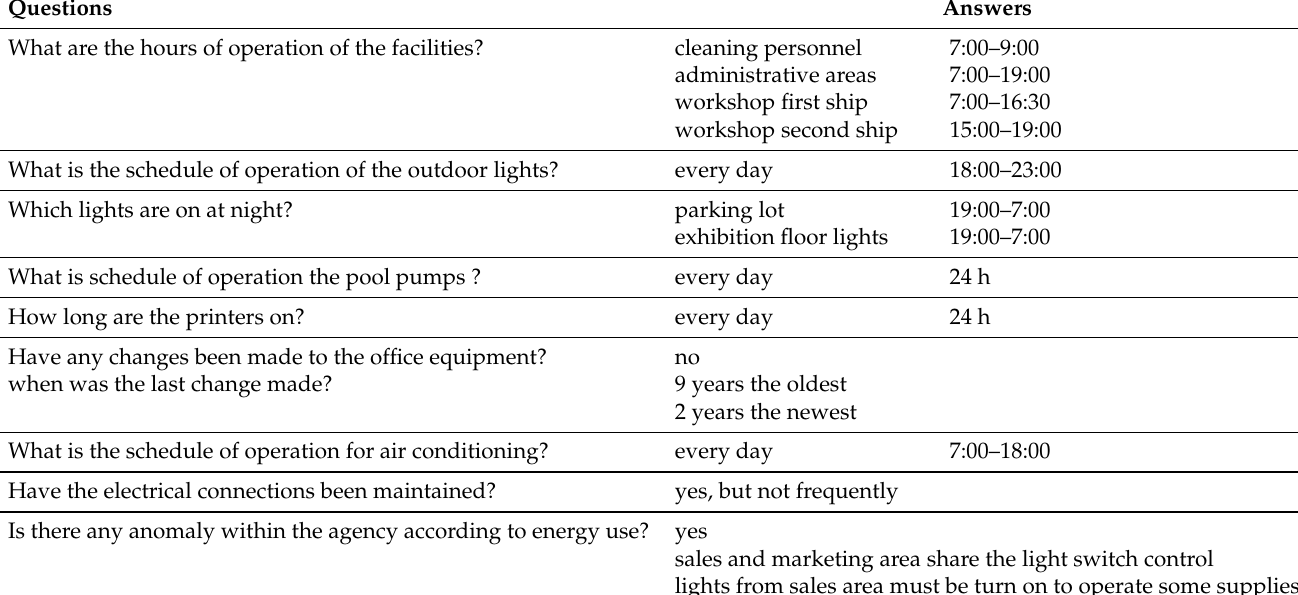
Table A1. Interview with the head of